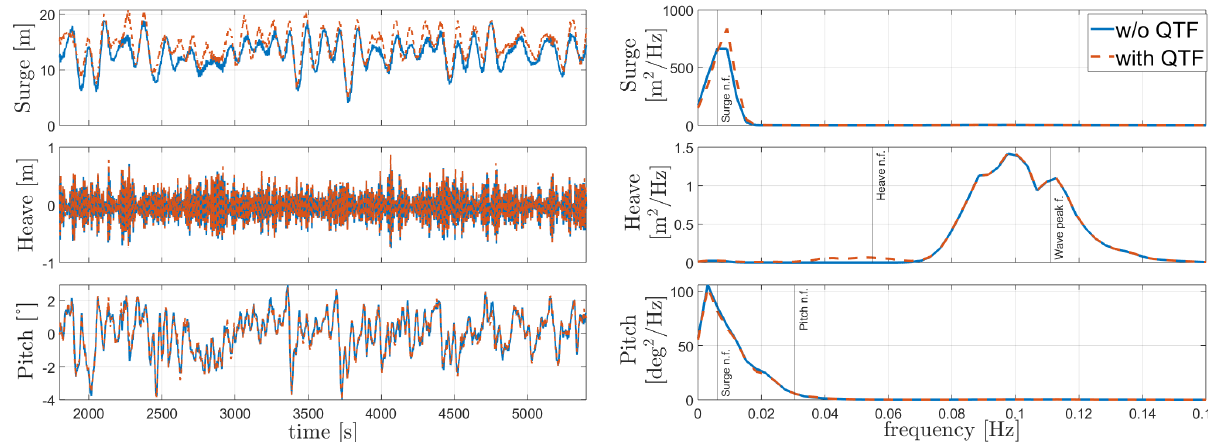
Figure 12. Activefloat response to NTM wind and ESS ( T p = 9s ,H s = 5 . 11m).